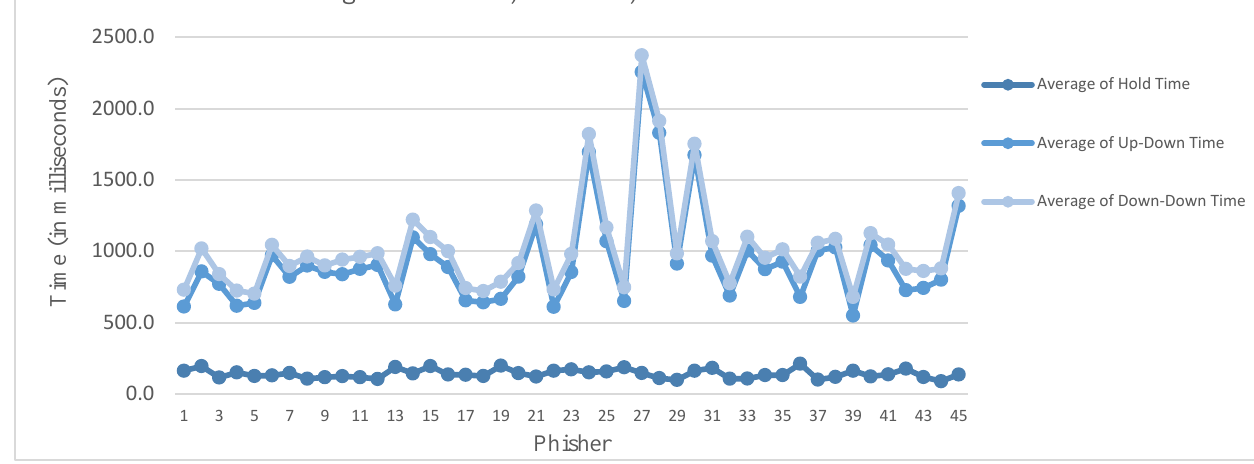
Figure 12. Average hold time, UD time, and DD time for each phisher.